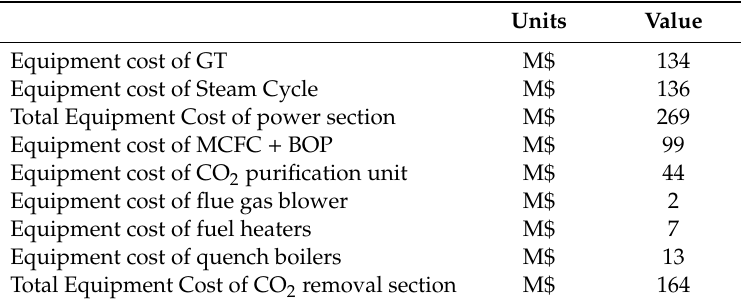
Table 15. MCFC cost evaluation outcomes.